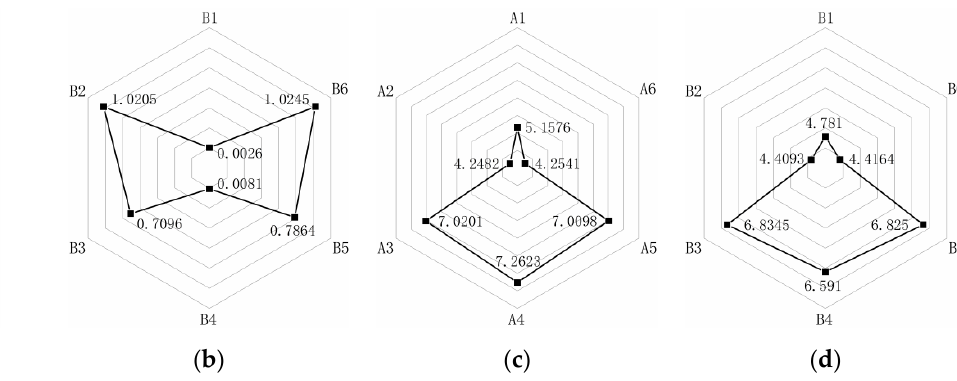
Figure 17. PPA (m/s 2 ) during double-train traffic: ( a ) PP H A of double-track tunnel; ( b ) PP H A of double-track tunnel with middle partition wall; ( c ) PPVA of double-track tunnel; ( d ) PPVA of double-track tunnel with middle partition wall; A1-A6 and B1-B6 here correspond to that of A1-A6 and B1-B6 in Figure 9.